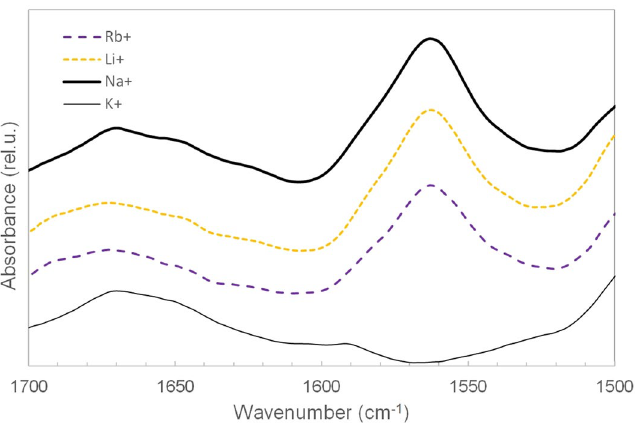
Figure 3. Infrared spectra of HepB in presence of 100 mM Na + , K + , Li + and Rb + at pD7.4 at 30 °C.